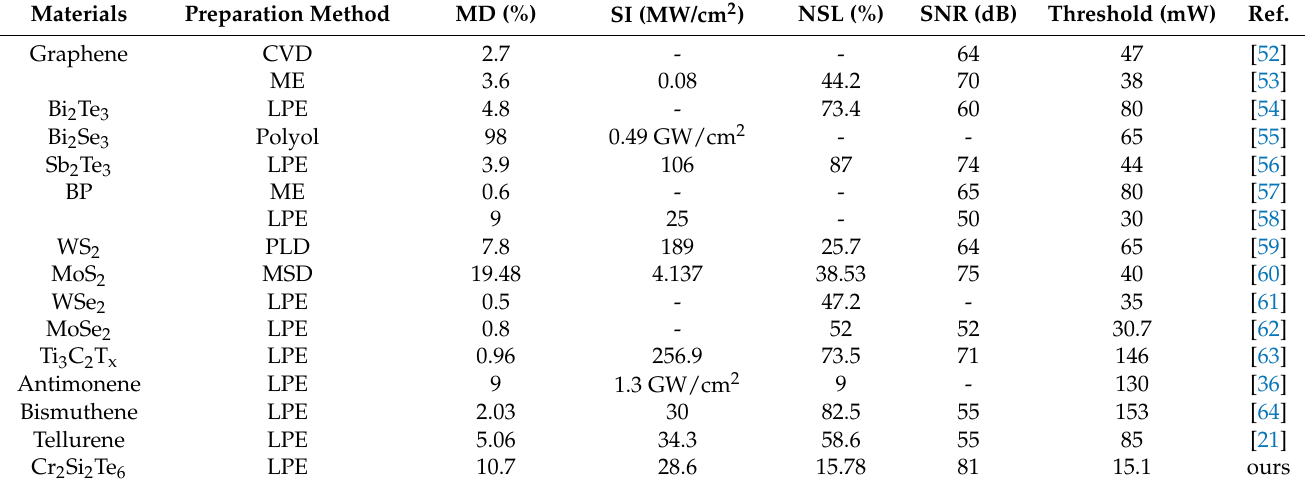
Figure 9. ( a ) Changing trend of the optical spectra of the harmonic order from 21st–49th, ( b ) changing trend of the FWHM and pulse width with the order of harmonics. Table 1. Comparison of threshold of 1.5 µ m mode-locked fiber lasers based on different 2D